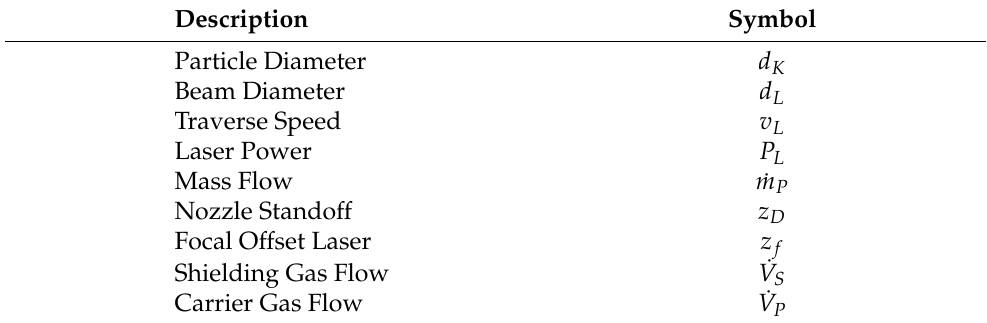
Table 4. Relevant process parameters of powder-based DED-LB processes. Compiled from [1,7] and